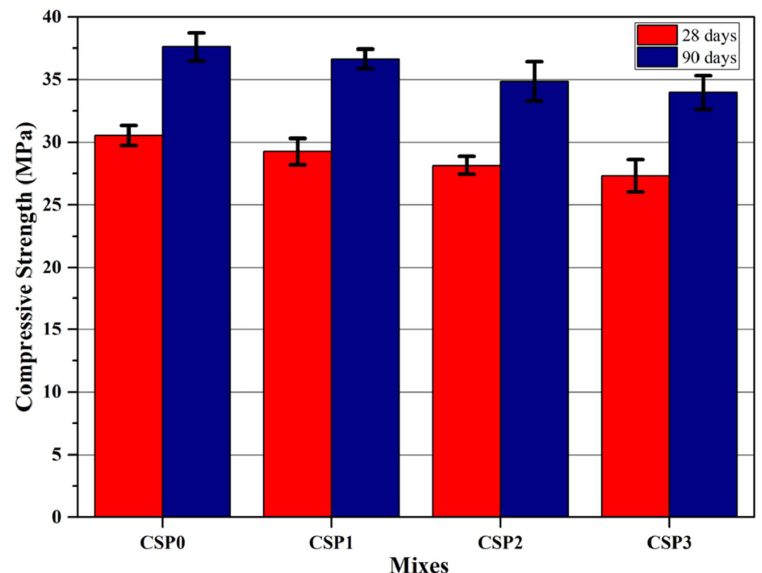
Figure 13. Compressive strength values of the control samples.